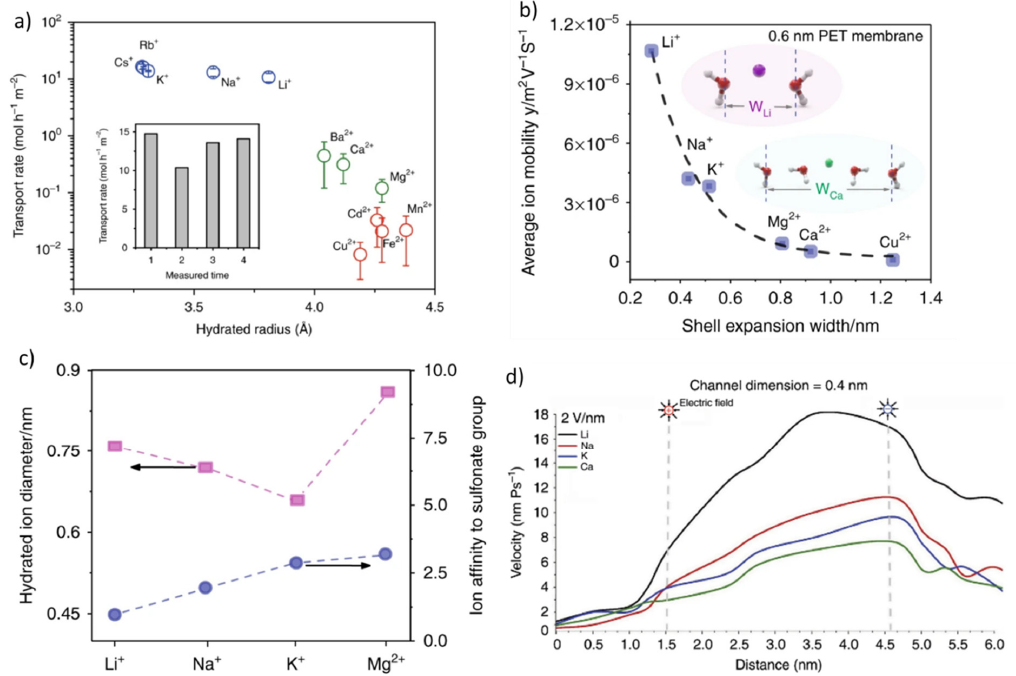
Figure 3. Effect of nanochannel size of Li-ion selectivity ( a ). The ion mobility vs. hydration shell ( b ). The hydration ions diameter of light metal cations ( c ). Comparison of velocity of Li + , Na + , K + , and Ca 2+ in 0.4 nm vermiculite nanochannel ( d ) Reprinted based on the open access license from [72,75]. The size of the free volume, the charge of the surface, and the external driving forces applied across the membrane stack will influence the rate of diffusion and the perm-se- lectivity of Li ions diffusion compared to other cations across membranes [72]. The dimen- sion of the micropores and the loss of the hydration shells of the ions upon entering the channels are crucial to diffusion since these critical dimensions are typically smaller than the hydrated radii of most alkali metal ions (Figure 3b). The charge distribution and den- sities across the micro-channels will also dictate the rate of ion transfer and negatively charged moieties, and polymer backbones should be used for cation diffusion and to repel anions. The impact of the pendant cation exchange groups across ion exchange resins was evaluated to optimize Li+ ion perm-selectivity. Sulphonate [76,77], carboxylic [78], as well as hydroxide groups were found to offer weak interactions supporting ion hopping (Fig- ure 3c). Ion affinity to -SO 3 − was found to follow the trend Mg 2+ > K + > Na + > Li + , thus promoting the facile release of Li ions. The application of the external electric field during ED promotes the migration and depletion of ions from the feed side across the membrane stack. The enrichment of ions across the membranes and on the permeate side results in a strong polarization. This mechanism, which creates electro-convection at the membrane surface but also water stripping, may lead to changes in ion selectivity. Such limiting considerations in designing Li-ion-selective membranes are created due to the high diffusivity and response rate in Li to variations in current densities (Figure 3d) [72]. 3.1.2. Li extraction Case Studies with ED Lithium extraction from brines by ED has been demonstrated from model solutions, industrial wastewaters, and natural lake waters. The impact of the Mg 2+ /Li + ratio, feed temperature (15 to 30 °C), feed flow rate, solution residence time, and current densities across the membrane stack (5.9–13.8 A/m 2 ) were systematically investigated. The